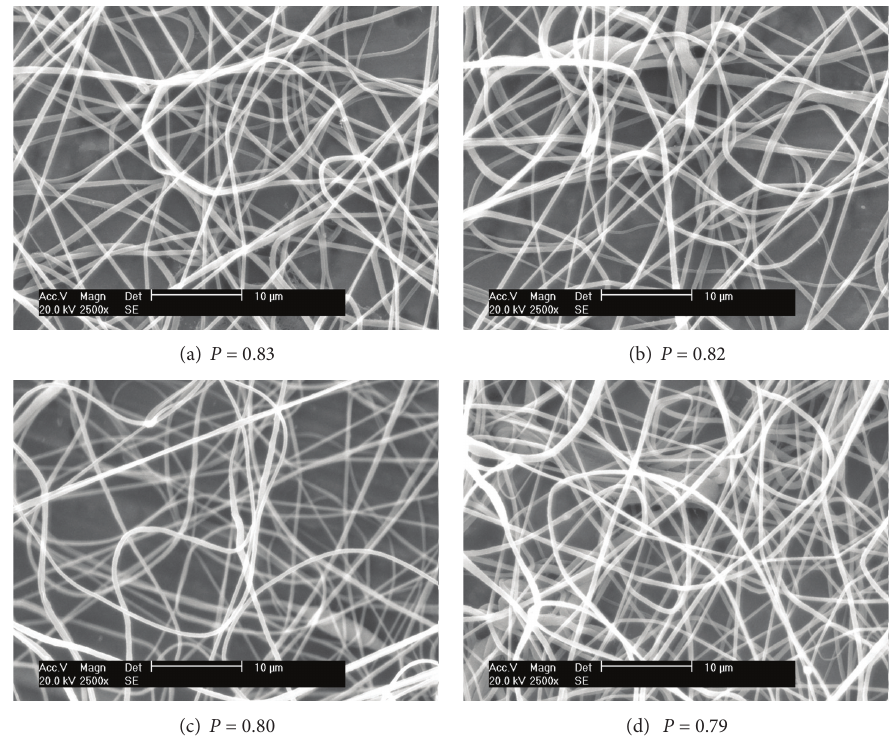
Figure 1: SEM images of 20 wt% PVdF and PVdF/Fe 3 O 4 fibre webs. Applied voltage: 22 kV; flow rate: 0.6mL hr −1 : (a) 100% PVdF; (b)